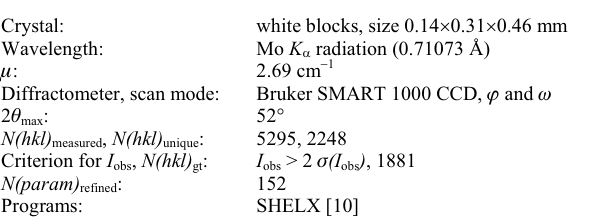
Table 1. Data collection and handling.